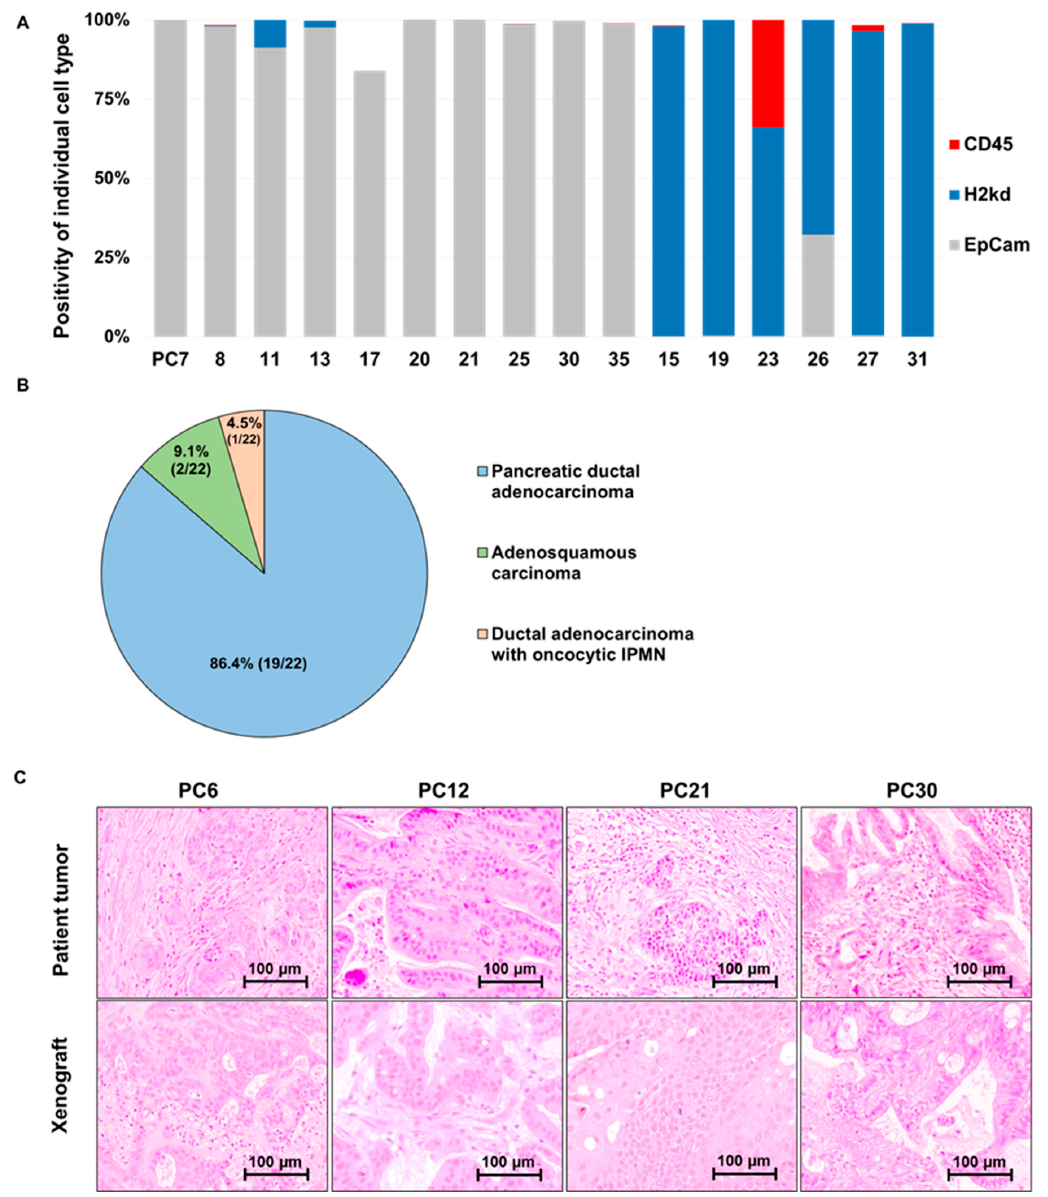
Figure 3. Characterization of established patient-derived primary cultures. ( A ) FACS analysis demonstrates epithelial identity of successfully established patient-derived in vitro culture as well as 6 cultures dominated with murine stromal cells as indicated by prevalence of murine H2Kd expressing cells. ( B ) Primary cell cultures (n = 22) could be established from human pancreatic cancers with different histology PC: Ductal adenocarcinoma (n = 19), adenosquamous carcinoma (n = 2), and ductal adenocarcinoma with oncocytic IPMN: Ductal adenocarcinoma with oncocytic intraductal papillary mucinous neoplasm (n = 1). ( C ) Upon xenotransplantation of established primary patient derived cultures, the xenograft tumors closely resemble the respective patient tumor